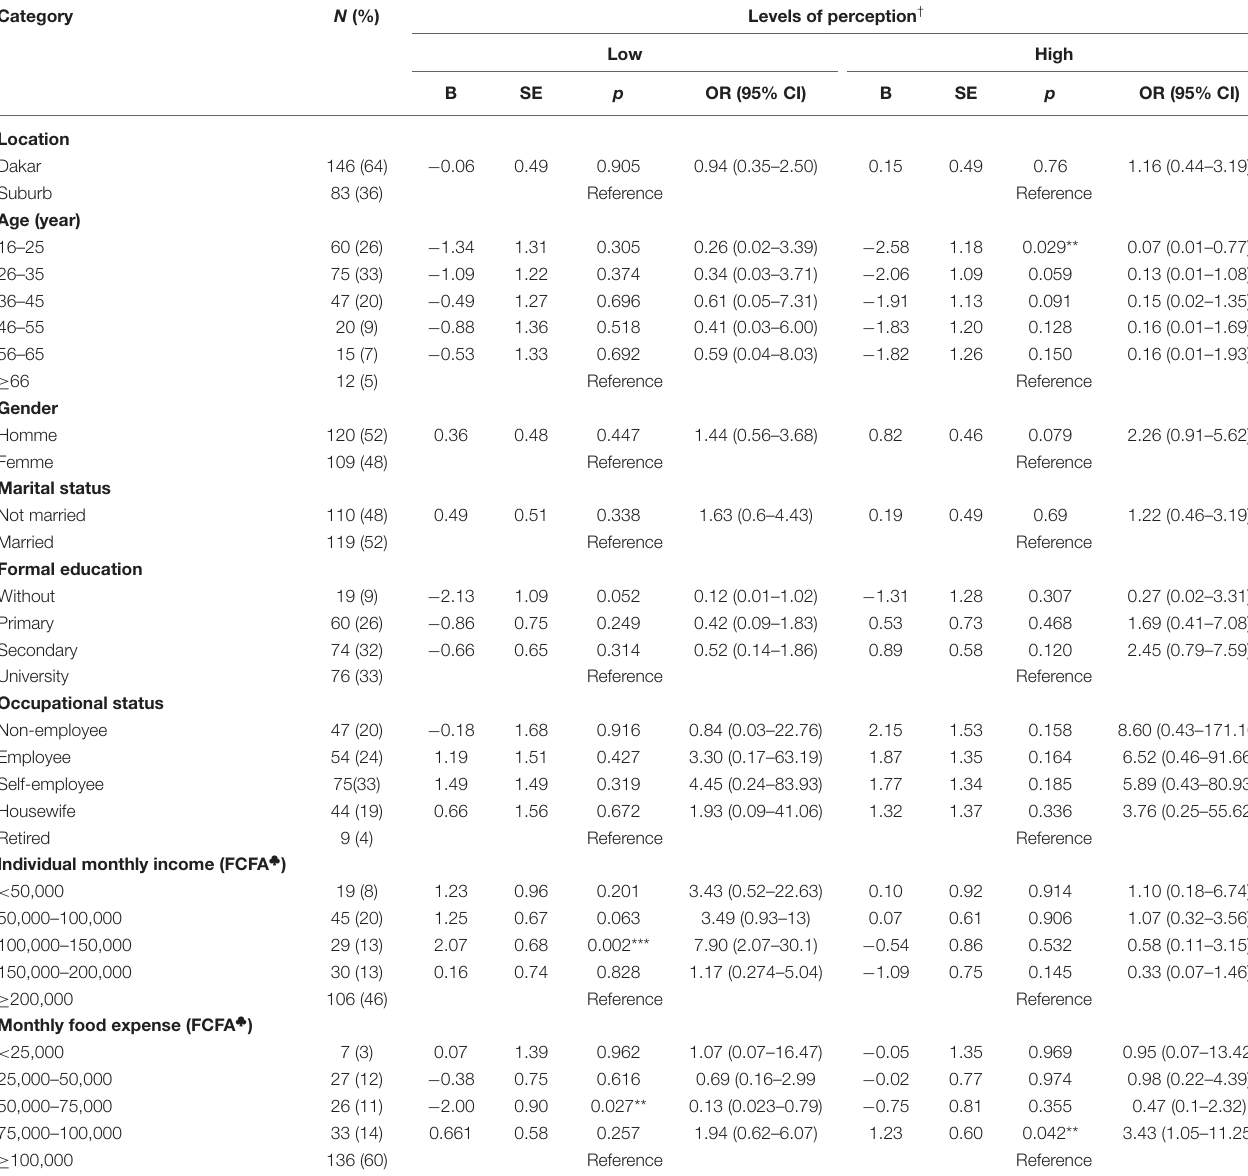
TABLE 4 | Multinomial logistic regression of factors associated to the levels of perception on the quality and safety of dibiterie meat ( n = 229).